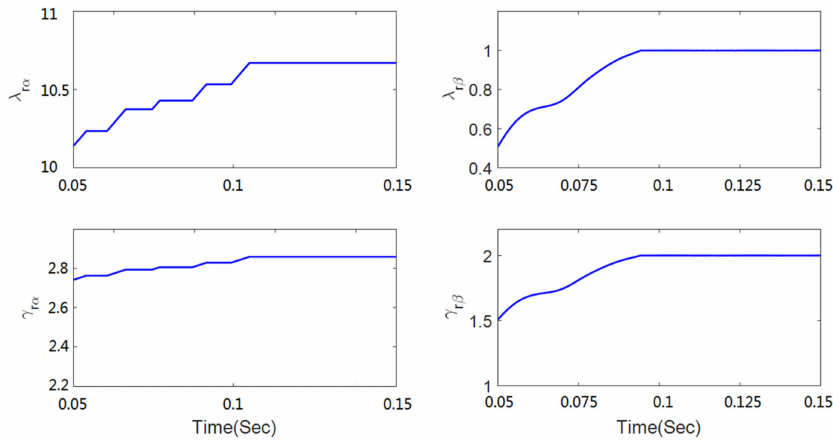
Figure 7. Control parameters for the proposed AGSOSM control law.